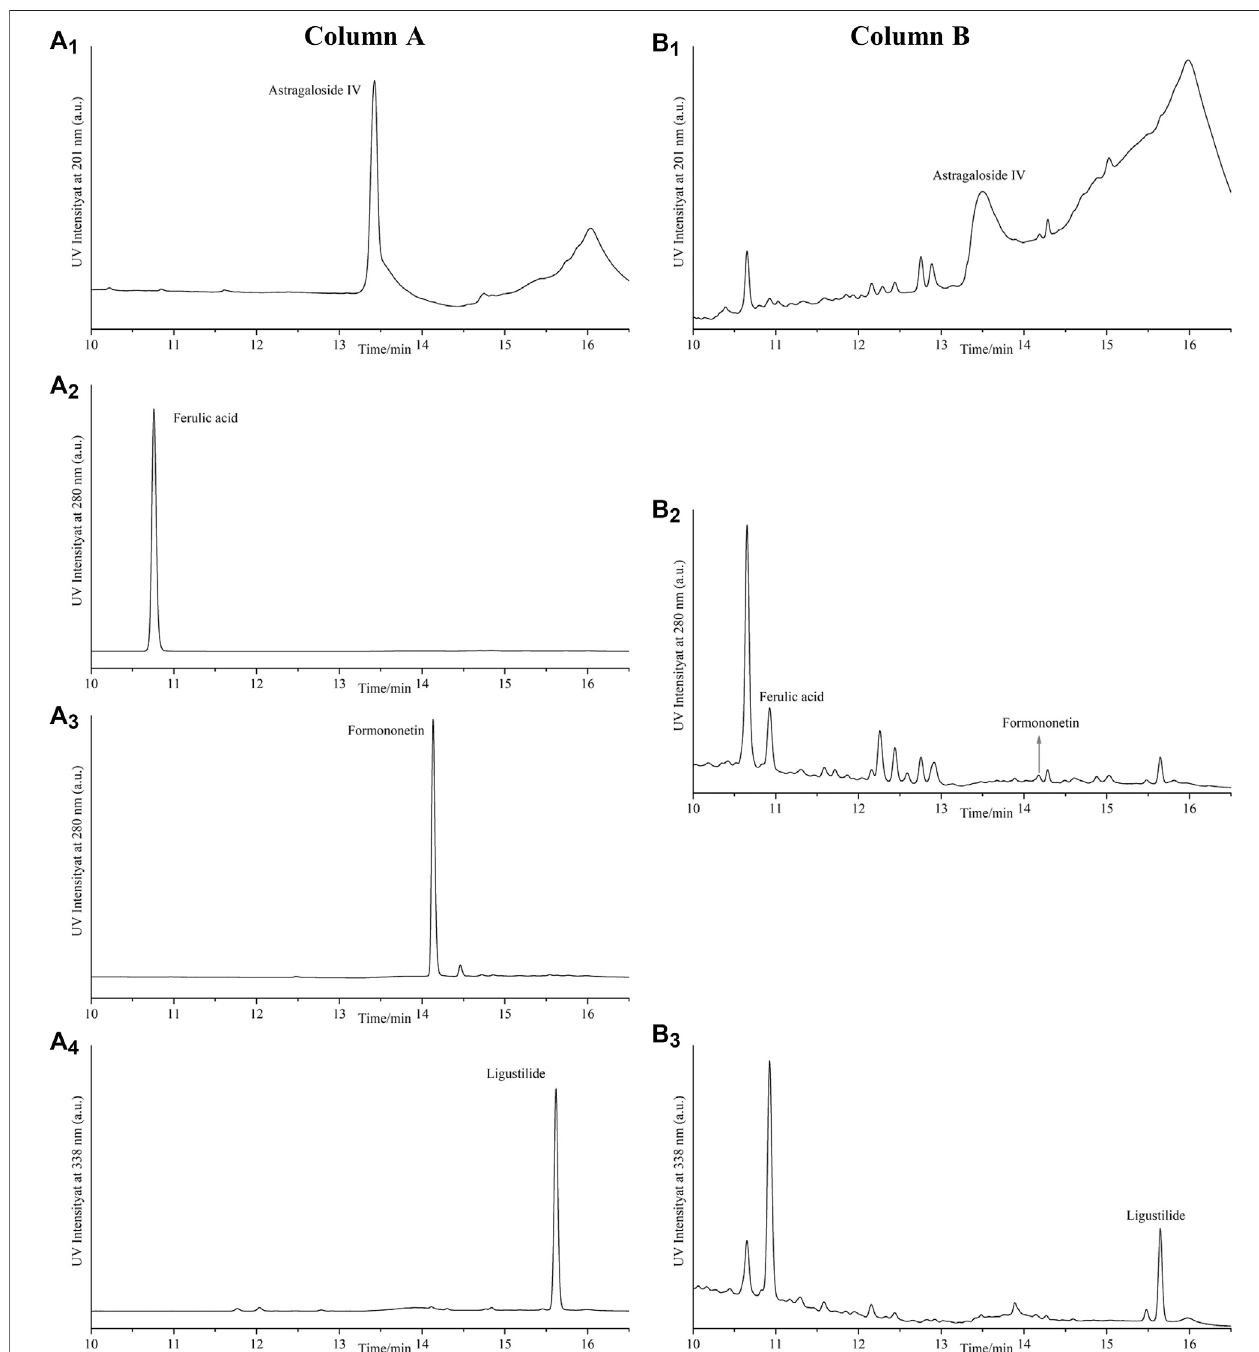
FIGURE3| HPLCanalysisoffourcompoundsinlyophilizedpowderofDBD.ColumnArepresentsHPLCchromatogramsofstandardsubstancesastragalosideIV (A 1 ) ,ferulicacid (A 2 ) ,formononetin (A 3 ) ,andligustalide (A 4 ) .ColumnBrepresentsHPLCchromatogramsofastragalosideIV (B 1 ) ,ferulicacid,andformononetin (B 2 ) and ligustalide (B 3 ) in lyophilized powder of the DBD